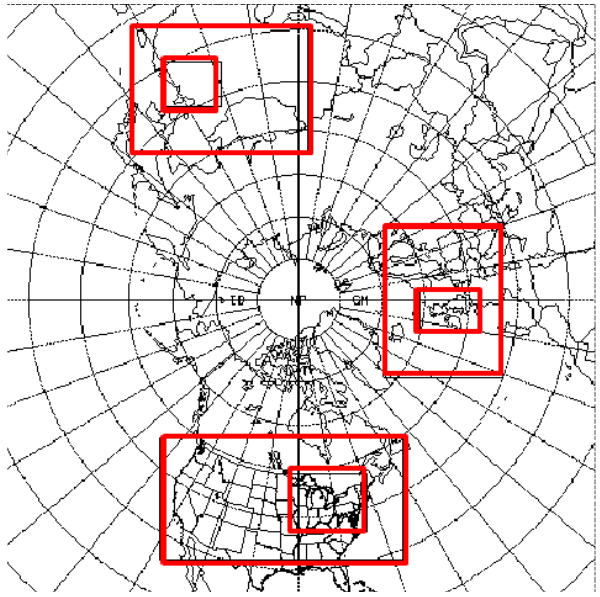
Fig. 1. Parent domain (45 km, black) and inner nests (15 km and 5 km, red) used for the ARCTAS simulations.